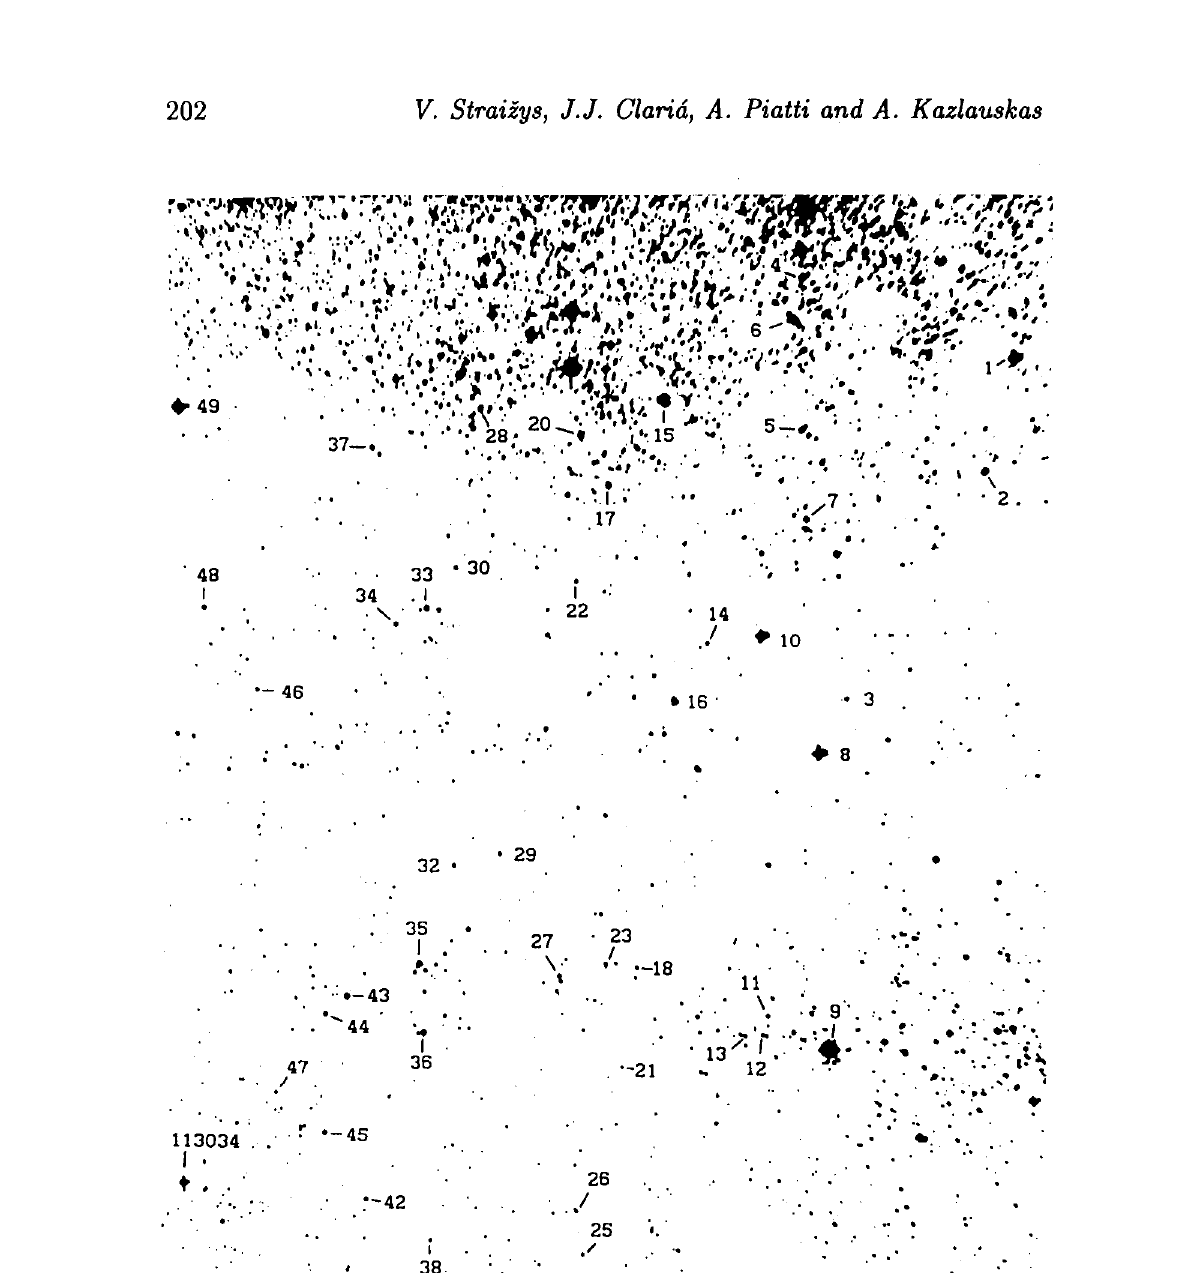
Fig. la. Identification chart of stars measured in the Coalsack